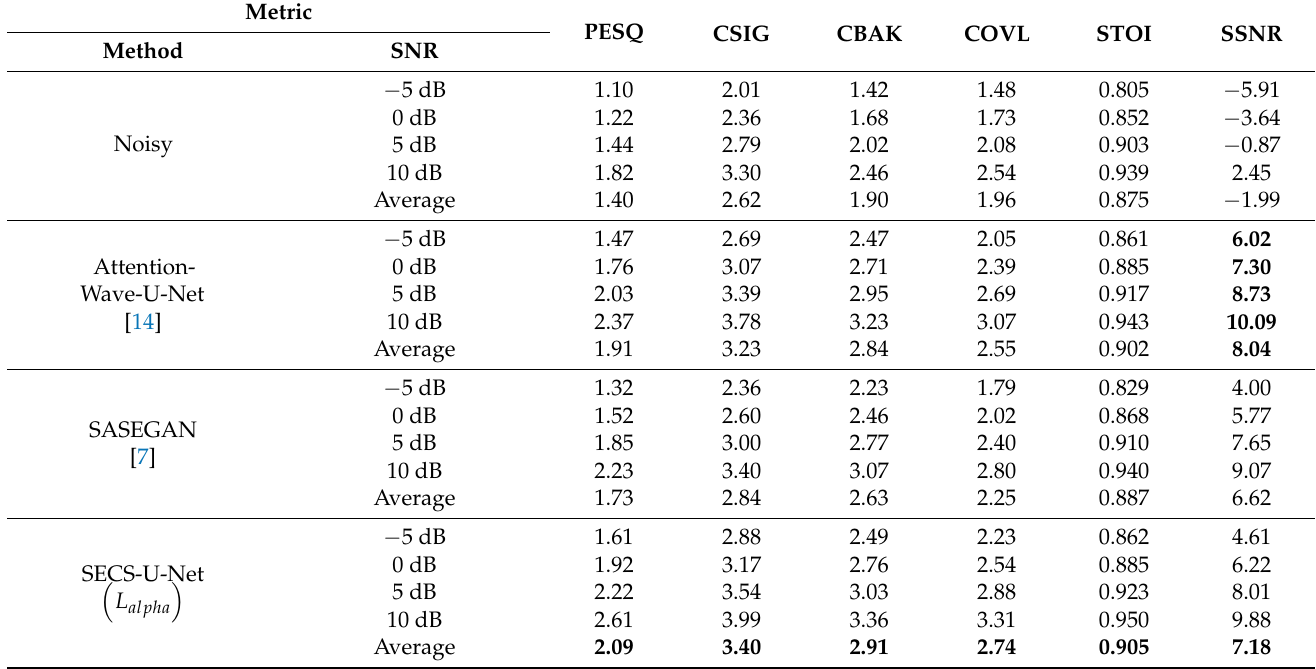
Table 5. Objective evaluation results of different models under unseen noise in open dataset (the bold indicates our metric scores and the metric scores that exceed ours in the reference models).